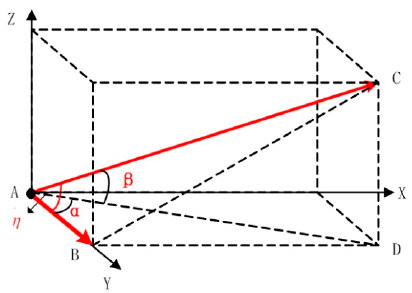
Figure 3. The basic model of spatial geometry.